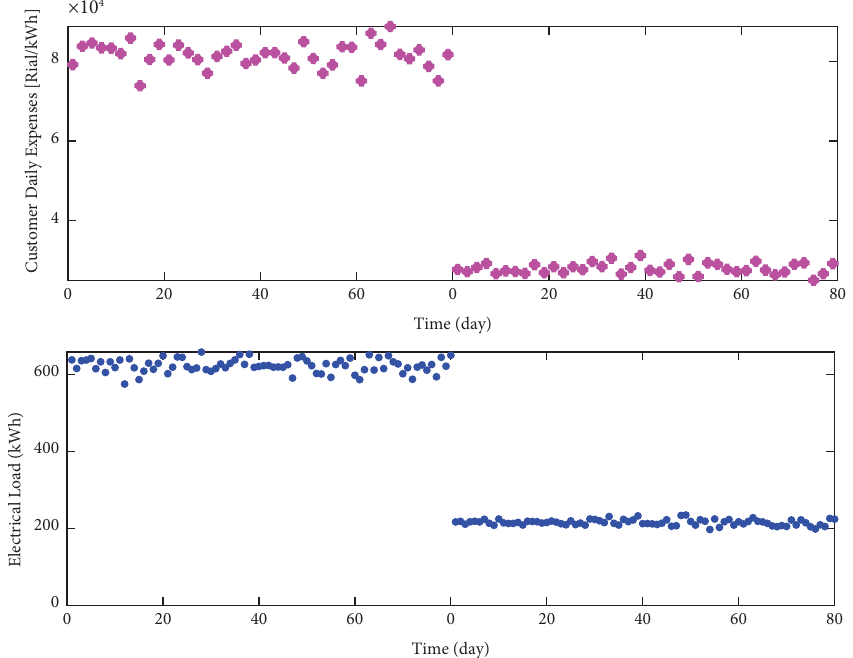
Figure 10: Average daily cost and consumption of the electrical